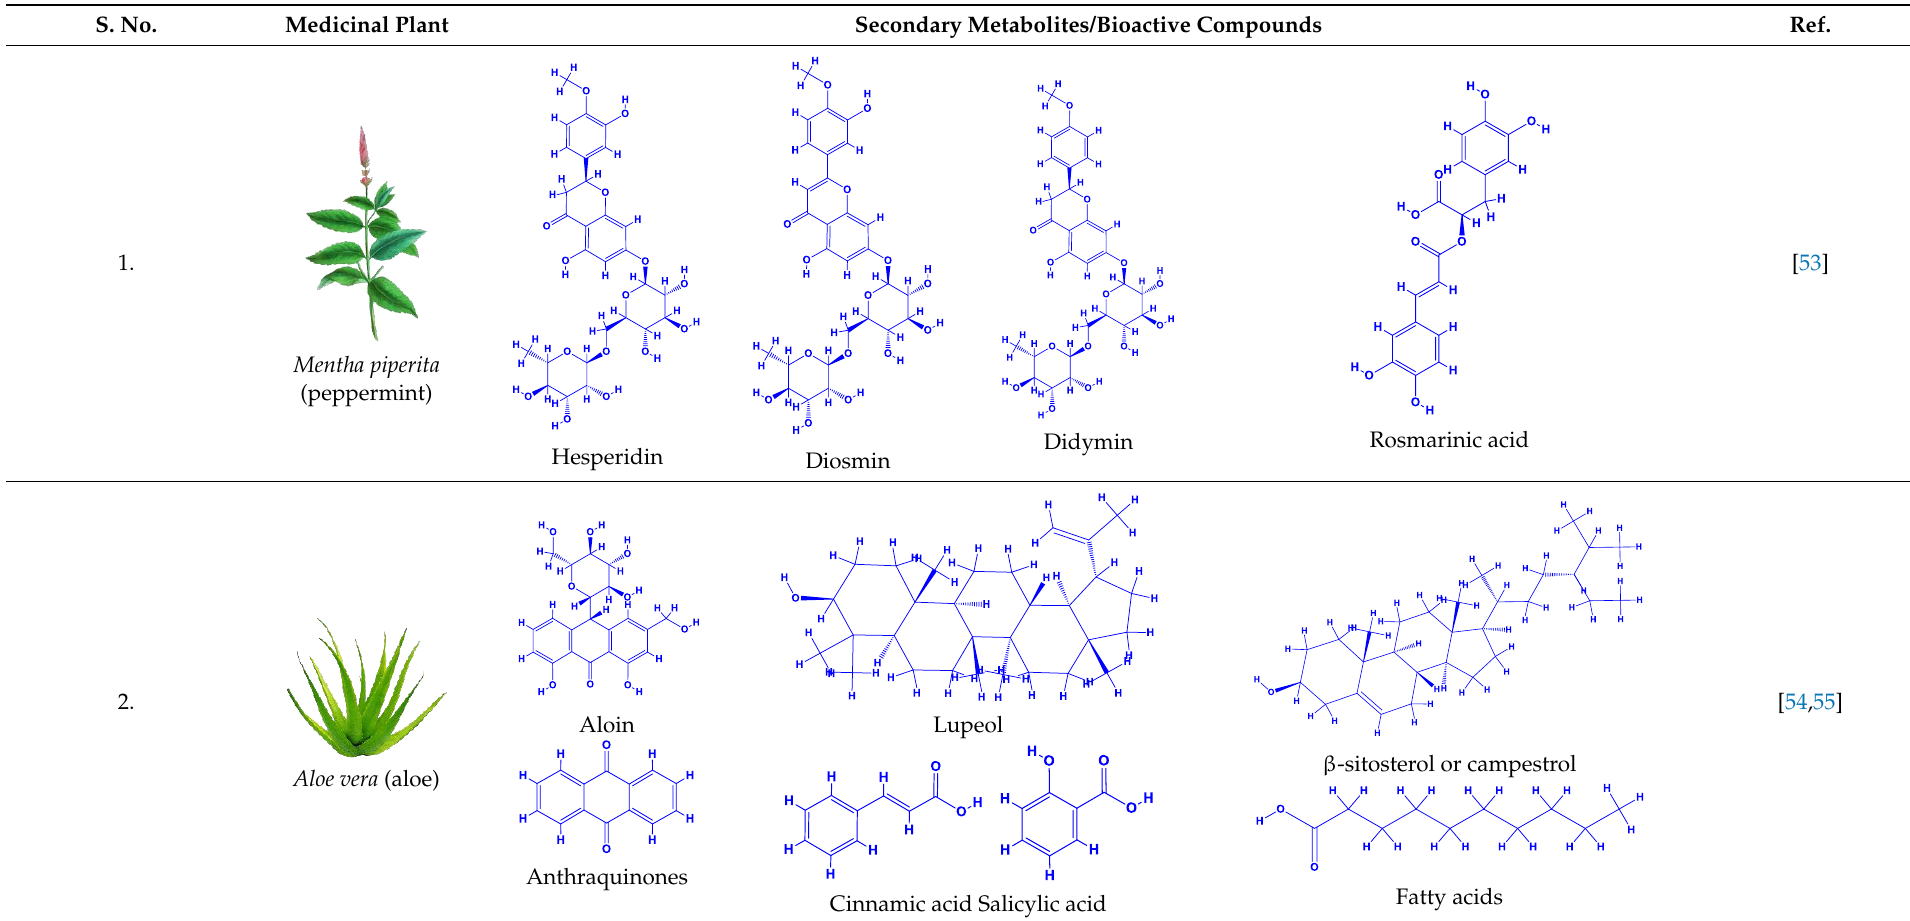
Table 1. Secondary metabolites synthesized by some important medicinal plants.